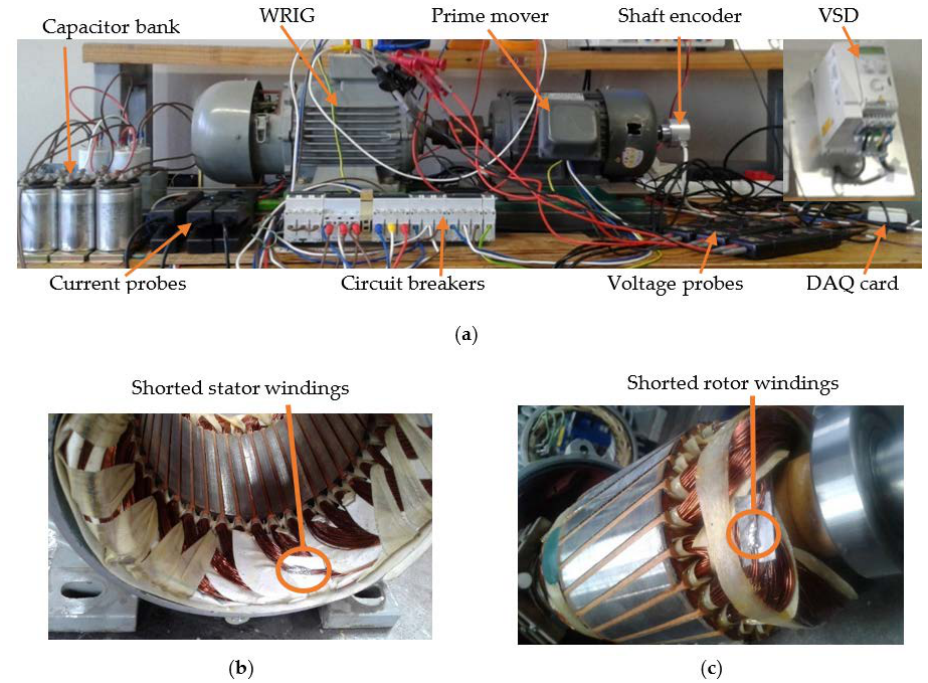
Figure 2. ( a ) Experimental layout; ( b ) Stator winding inter-turn fault; ( c ) Rotor winding inter-turn fault.